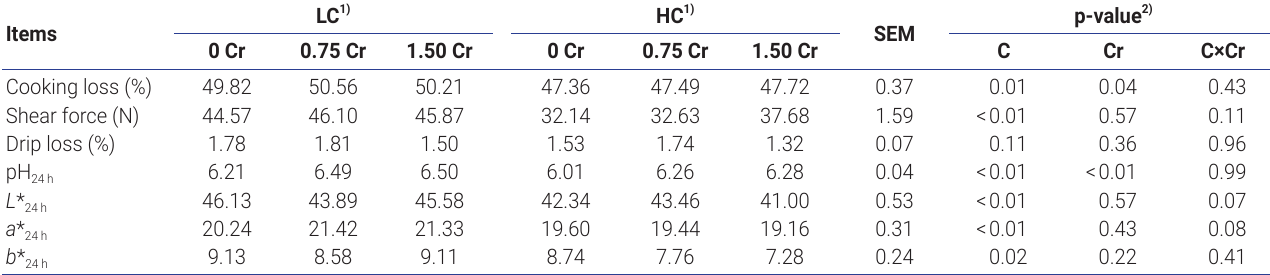
Table 7. Effects of concentrate level and Cr-Met supplementation on meat quality characteristics of Tan lambs